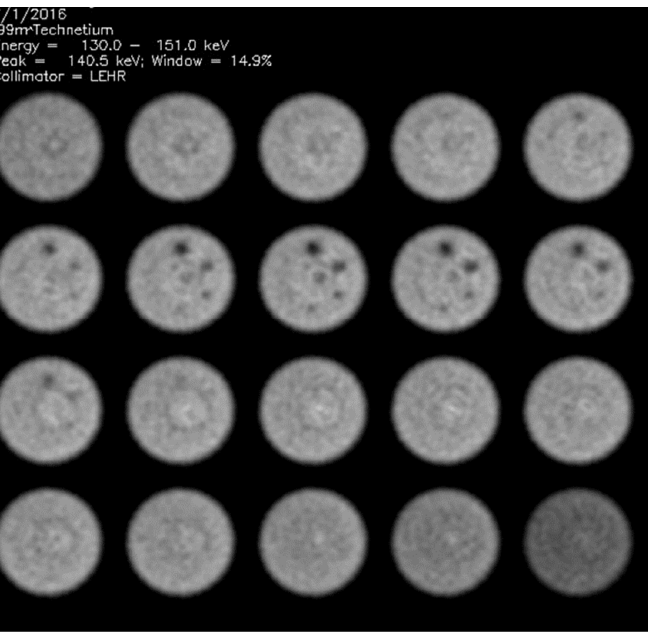
Figure 3. Example of images related to the uniform sections and spheres sections of a phantom, which both readers scored“3”, for probably significant concentric ring artifacts, in both sections.